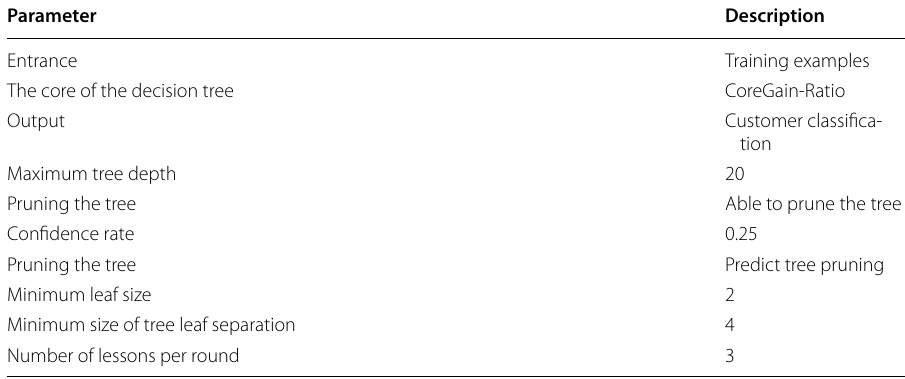
Table 8 Characteristics of the C4.5 decision tree algorithm to analyze the portfolio and classify customers